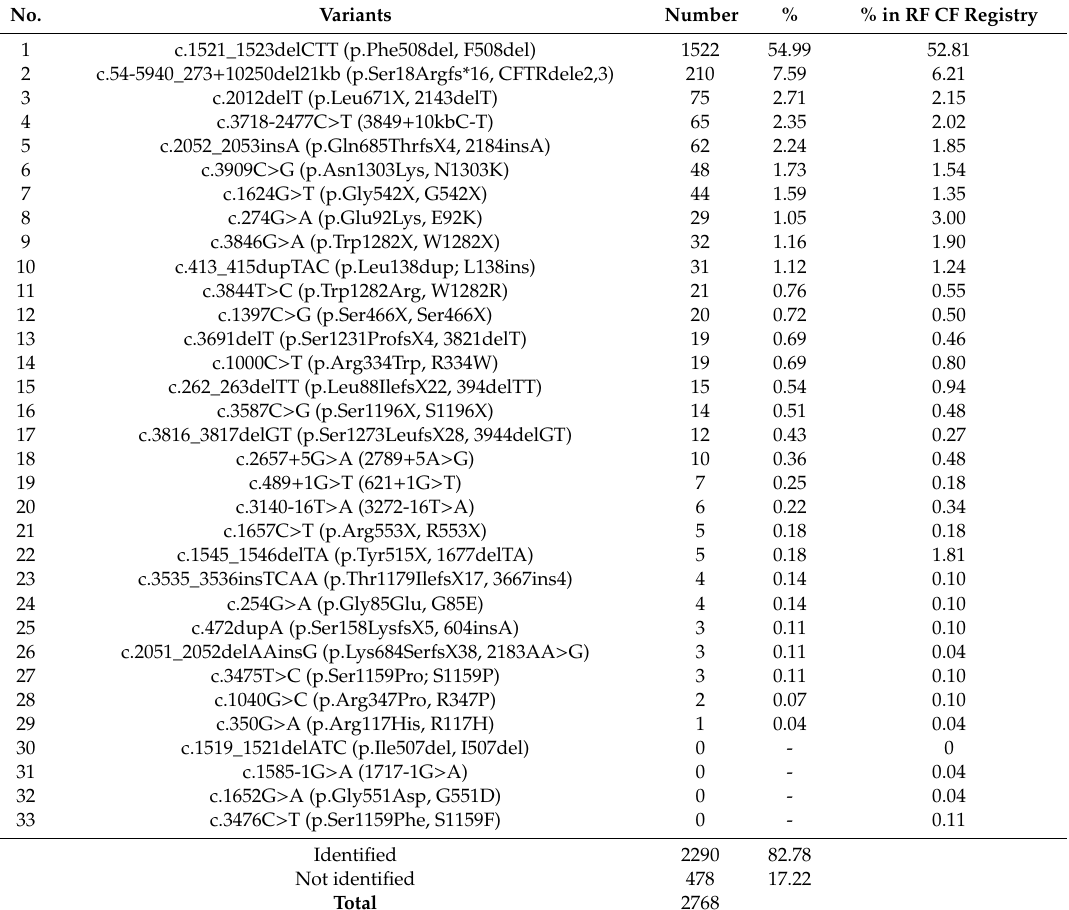
Table 1. Frequencies of 33 variants of CFTR gene in a sample of 1384 ethnic Russians and in a nationwide sample of CF patients (RF CF Registry)